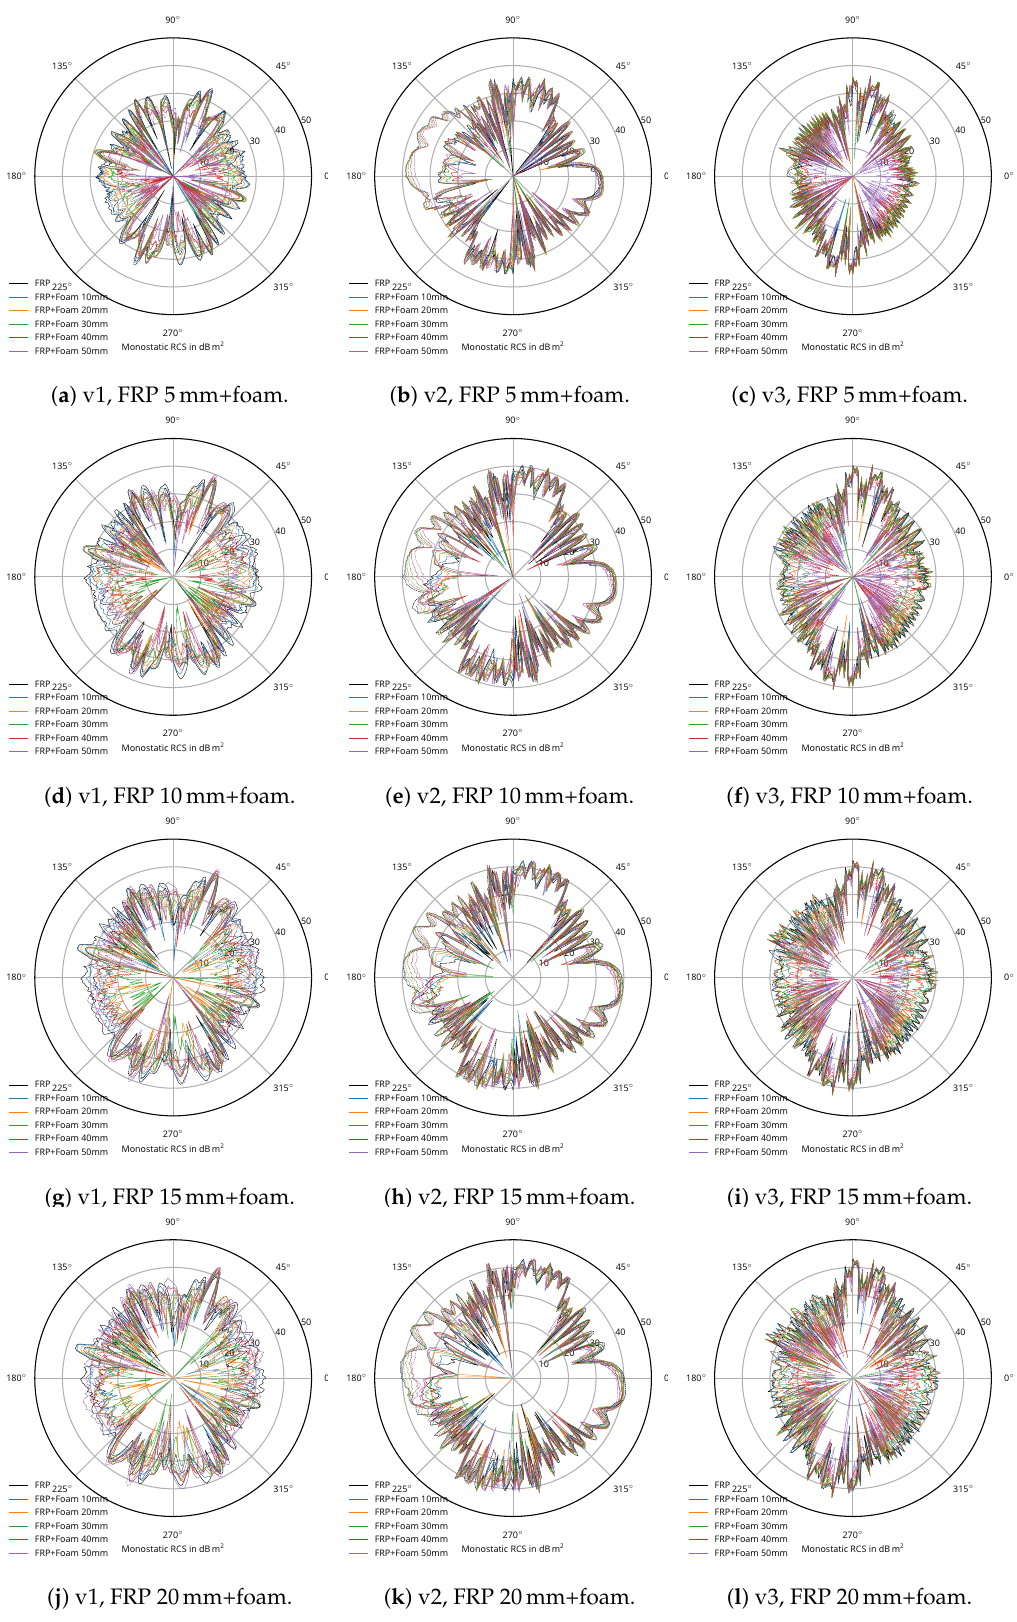
Figure 6. Monstatic RCS (in dBm 2 ) of the rotor blades (left to right) composed of a layer of FRP of different thickness (downwards) and a layer of foam of different